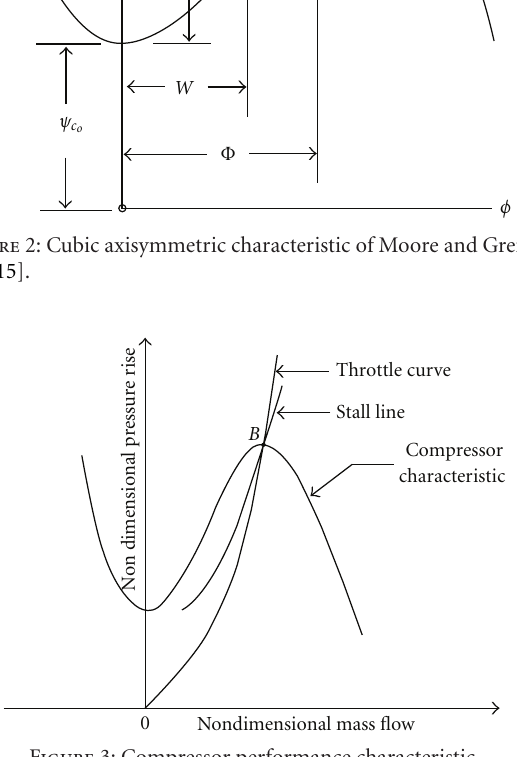
Figure 3: Compressor performance